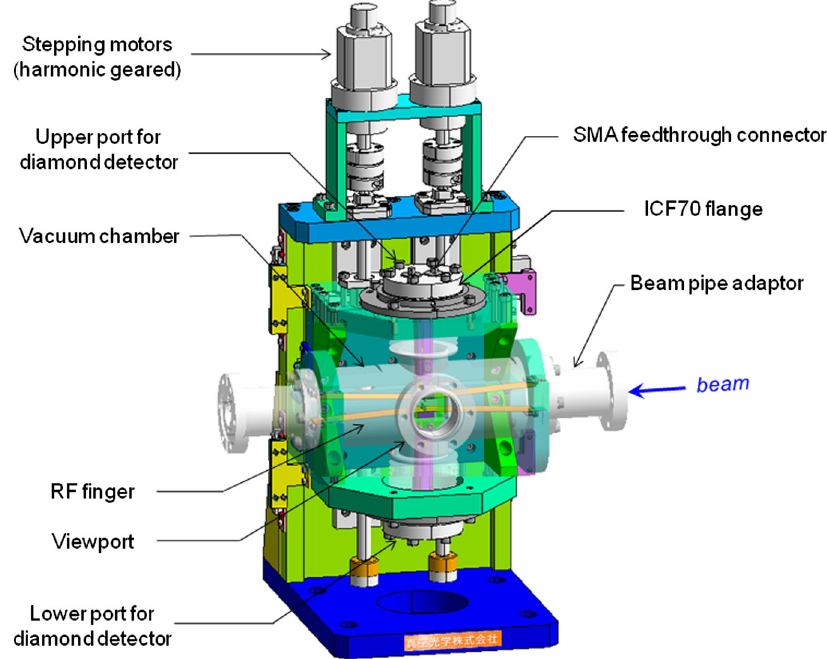
FIG. 16. Illustration of the beam halo monitor employed in SACLA.